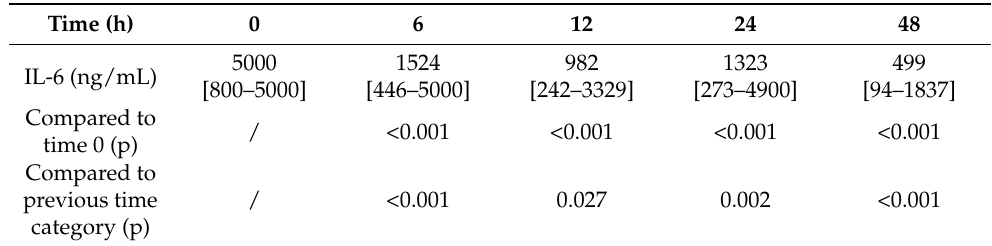
Figure 2. Serum interleukin-6 (IL-6) levels from the beginning of CytoSorb treatment to 48 h after the start of the first CytoSorb treatment. Values presented as median, interquartile range, minimum and maximum; not all outliers are shown. Comparison by paired Wilcoxon test. Values p < 0.012 were considered statistically significant and are indicated by *.